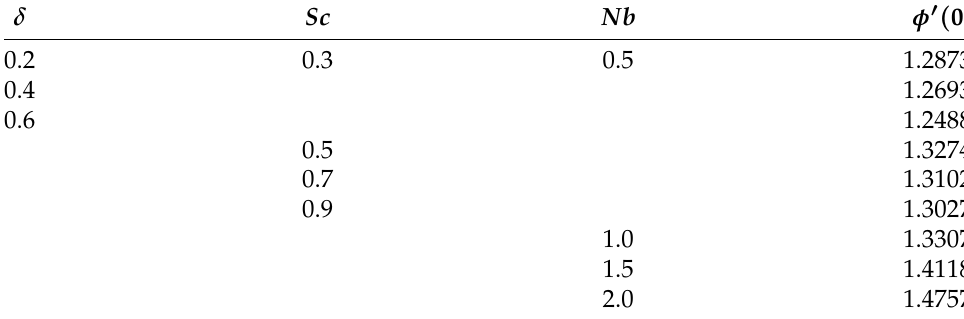
Table 4. Influence of δ , Sc , Nb on φ (cid:48) ( 0 ) .